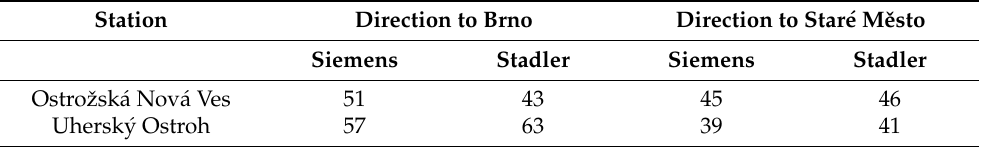
Table 8. Traction energy consumption [kWh] of stops in intermediate stations on the line